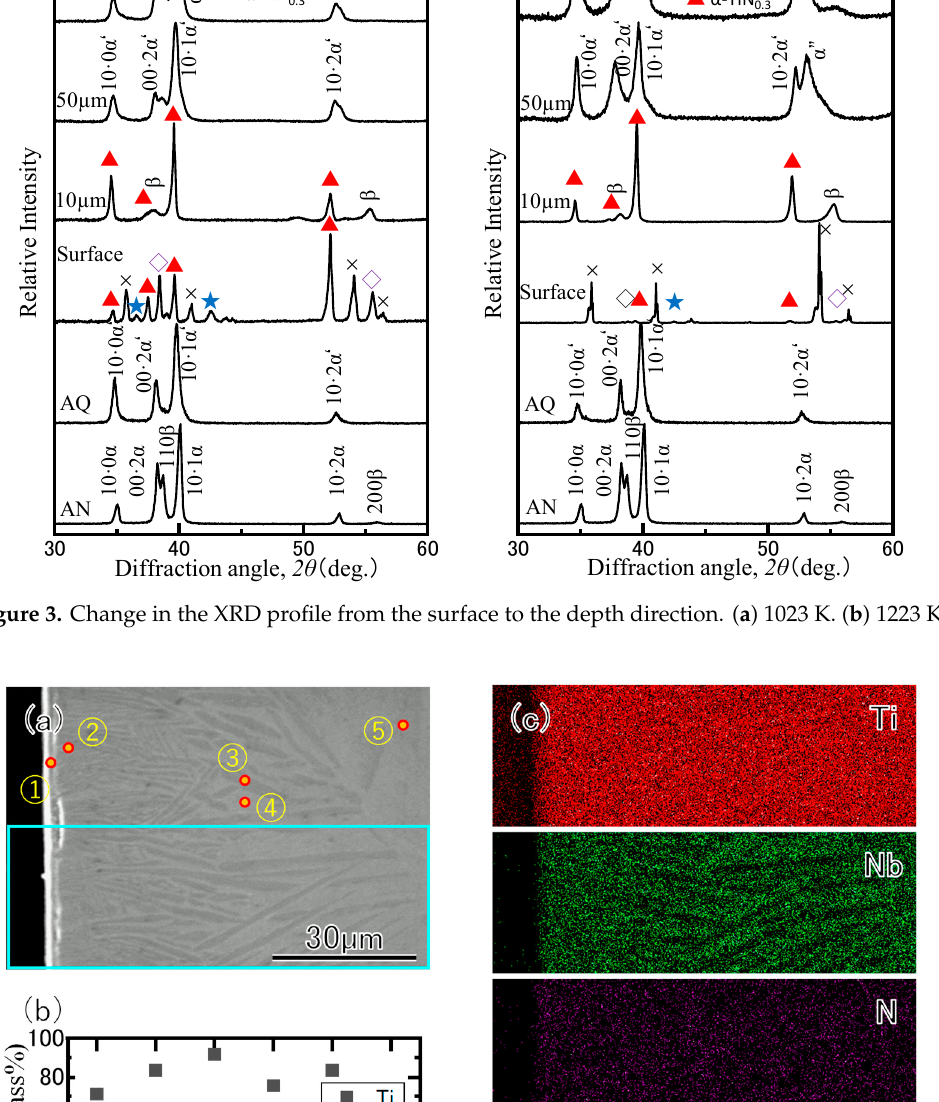
Figure 2. Micro Vickers hardness distribution from the surface after GNQP.